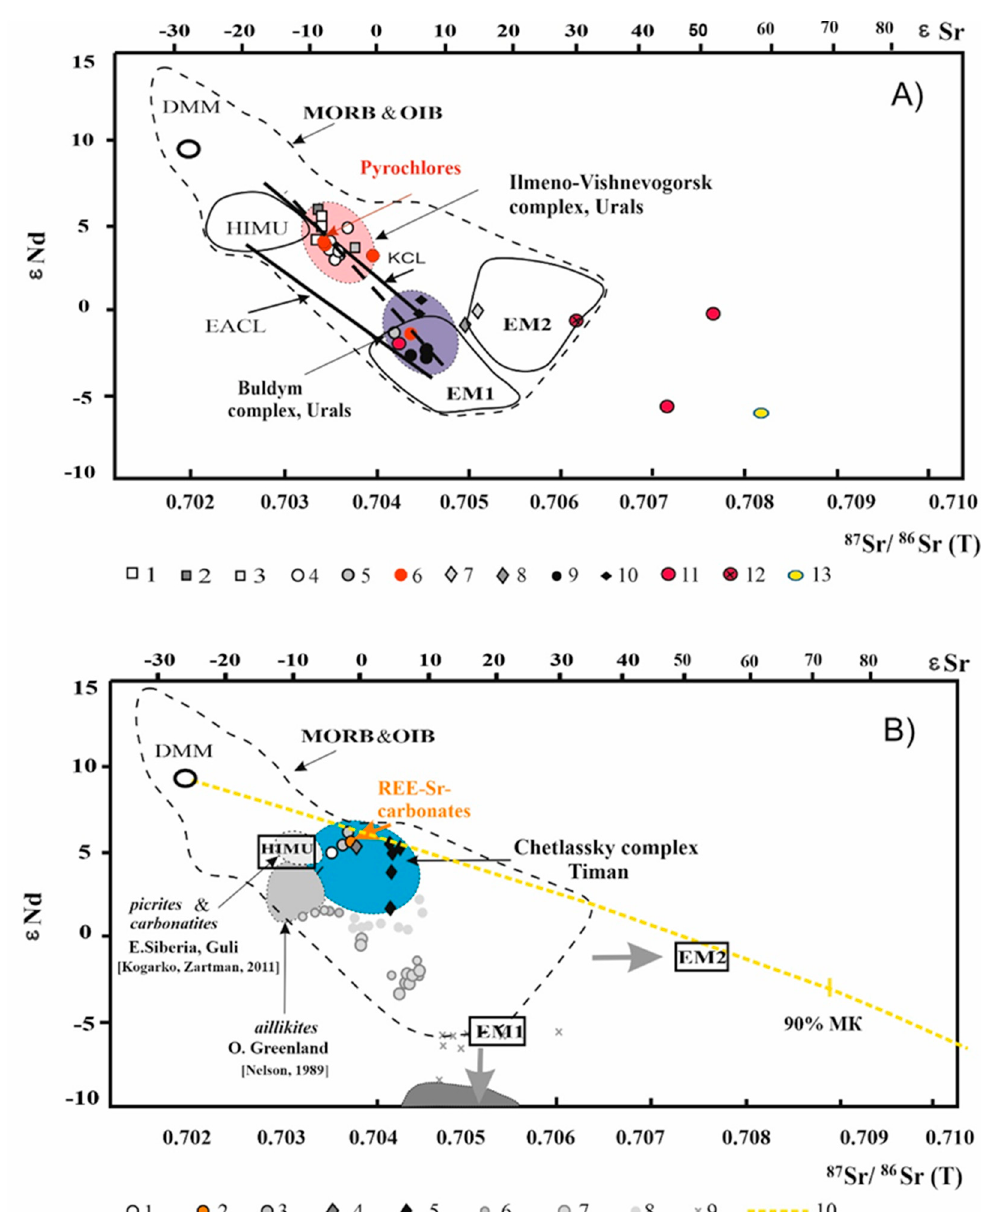
Figure 8. Nd—Sr isotope diagram for carbonatites and alkaline rocks of the Ilmeno–Vishnevogorsk (IVC) and Buldym carbonatite complexes, South Urals ( A ) and Chetlassky complex, Middle Timan (B ). ( A ) 1–6: Ilmeno–Vishnevogorsk miaskite-carbonatite complex: 1—miaskites of the Vishnevogorsk massif and CAB, 2—syenites, Vishnevogorsk massif, 3—antiperthite miaskite, CAB, 4—carbonatites in miaskites of the Vishnevogorsk massif and CAB, 5—carbonatites from the exocontact halos of Vishnevogorsky massif, 6—pyrochlores; 7 − 11: Buldym ultramafic-carbonatite complex: 7—peridotite, 8—olivinite, 9—sövites III, 10—beforsites IV, 11—pyrochlores; 12—aeshinite; 13—calciphyres of the host Vishnevogorsk Series (PR 1 ). The initial isotopic compositions of rocks and minerals of the IVC and the Buldym complex were